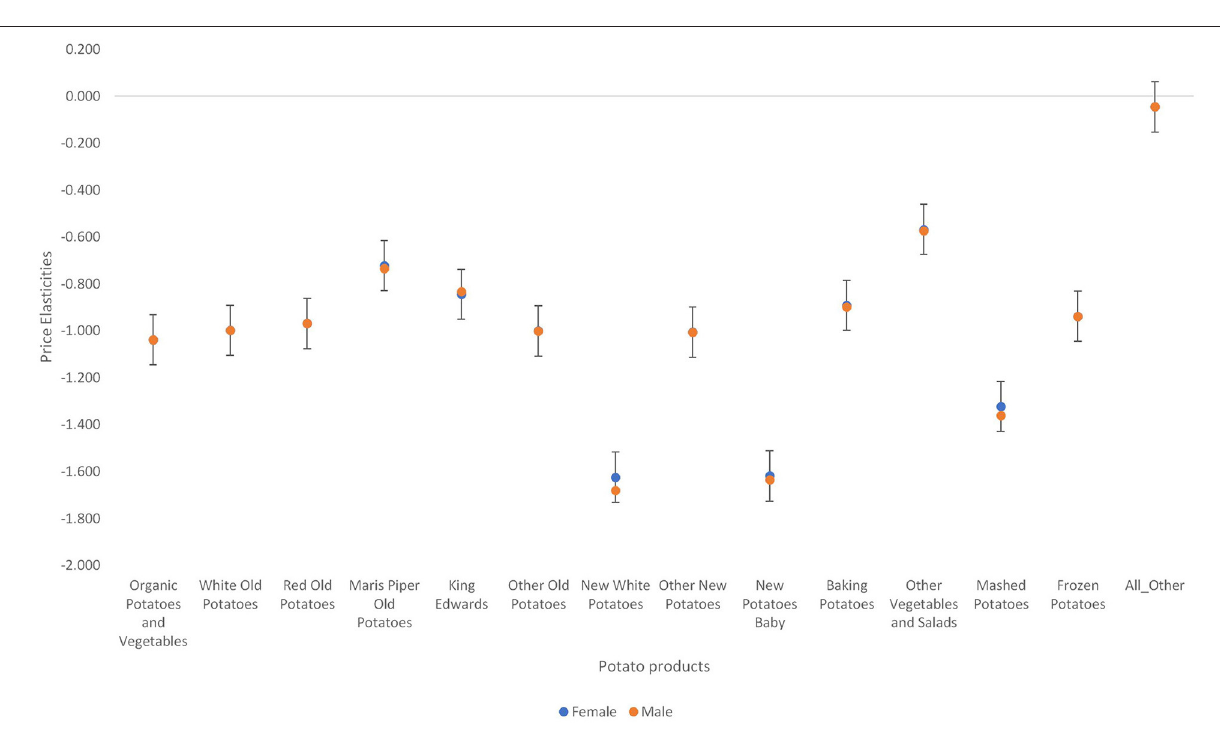
Frontiers in Nutrition |